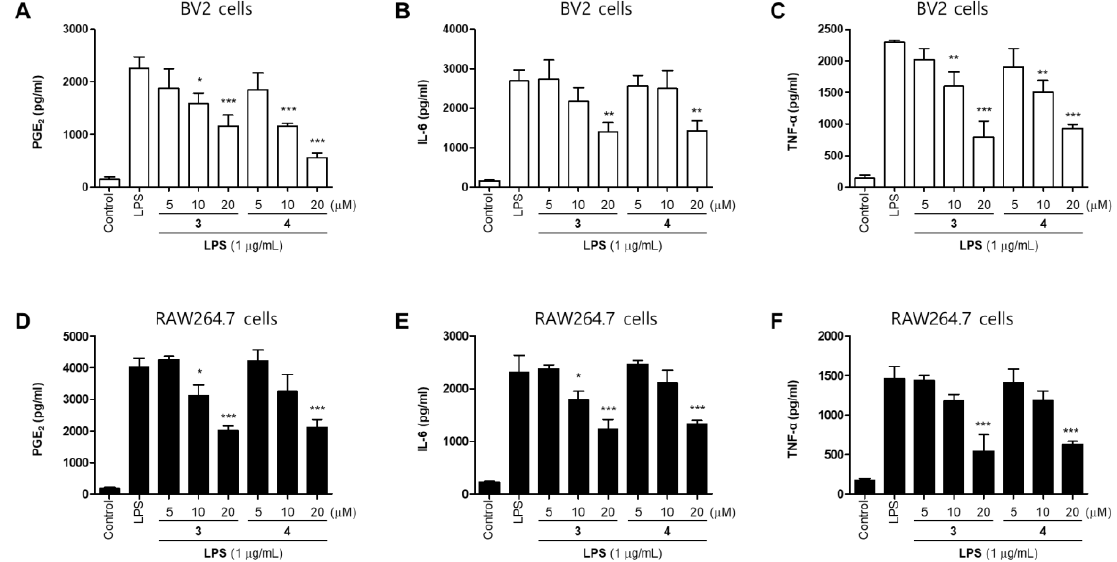
Figure 5. Inhibitory effects of compounds 3 and 4 on the level of PGE 2 ( A and D ), IL-6 ( B and E ), and TNF- α ( C and F ) in BV2 and RAW264.7 cells. The cells were pretreated for 2 h with various concentrations of compounds 3 or 4 and stimulated for 24 h with lipopolysaccharide (LPS; 1 μg/mL). Error bars represent mean ± standard deviation of three independent experiments. * p < 0.05, * * p < 0.01 and *** p < 0.001 compared with the LPS-treated group.